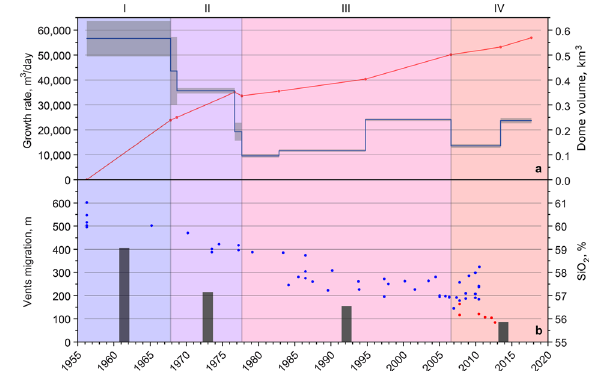
Fig. 9 Temporal evolution of the Bezymianny volcano characteristics in 1956-2017. a Dome volume (red line) and growth rate (blue line) changes. Gray horizontal bars indicate ranges of the eruption rates uncertainties of 2.1 – 31.2% related to inaccuracies in photogrammetric processing and DEMs alignment (see Table 1; Supplementary Table 1; and Error estimation section in Data and Methods). b Range of vents migration (black vertical bars) at the different stages of regrowth and changes in SiO 2 content (blue dots from 37 and red dots from 56 ). I – IV — stages of regrowth: I – endogenous, II – exogenous (extrusive), III – exogenous (extrusive – effusive), IV – stratocone